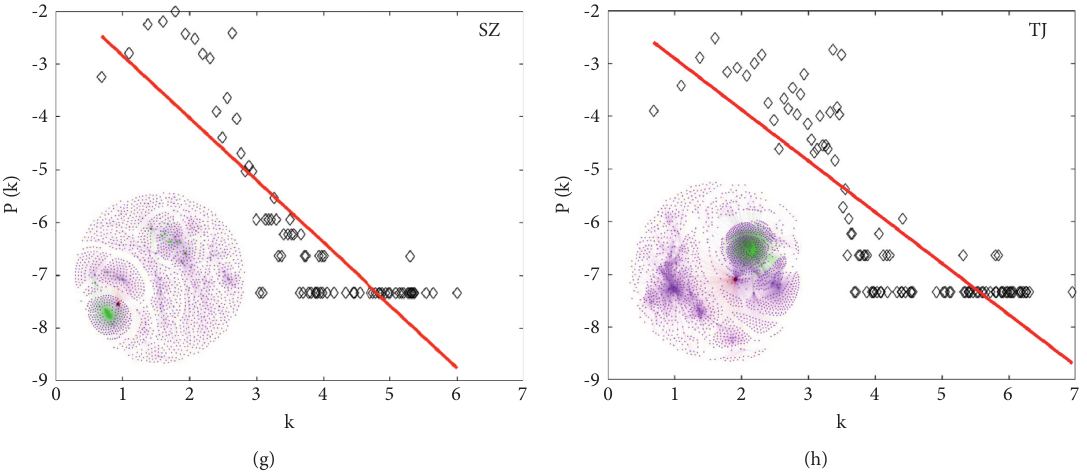
Figure 3: Sample data of carbon prices and their descriptive statistics.